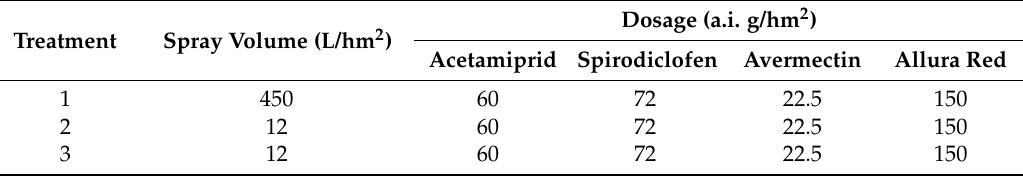
Table 2. Treatment for insecticide dosage.